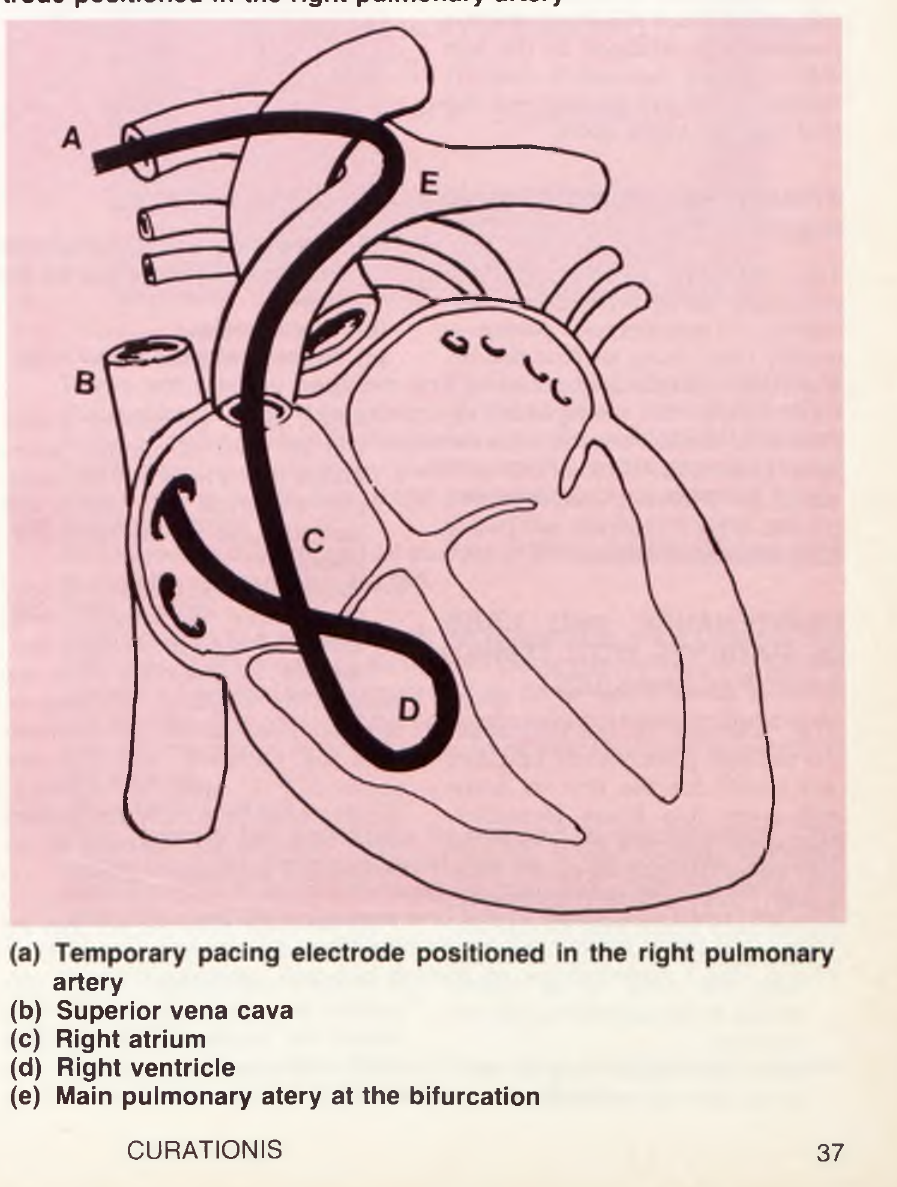
Figure 6 Diagrammatic representation of a temporary pacing elec­ trode positioned in the right pulmonary